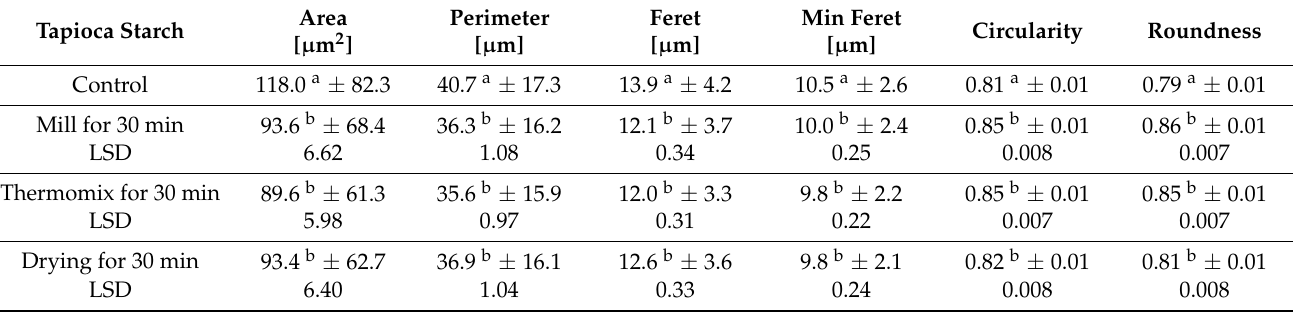
Table 6. Comparison of measurements of tapioca starch granules before (control) and after grinding and drying.